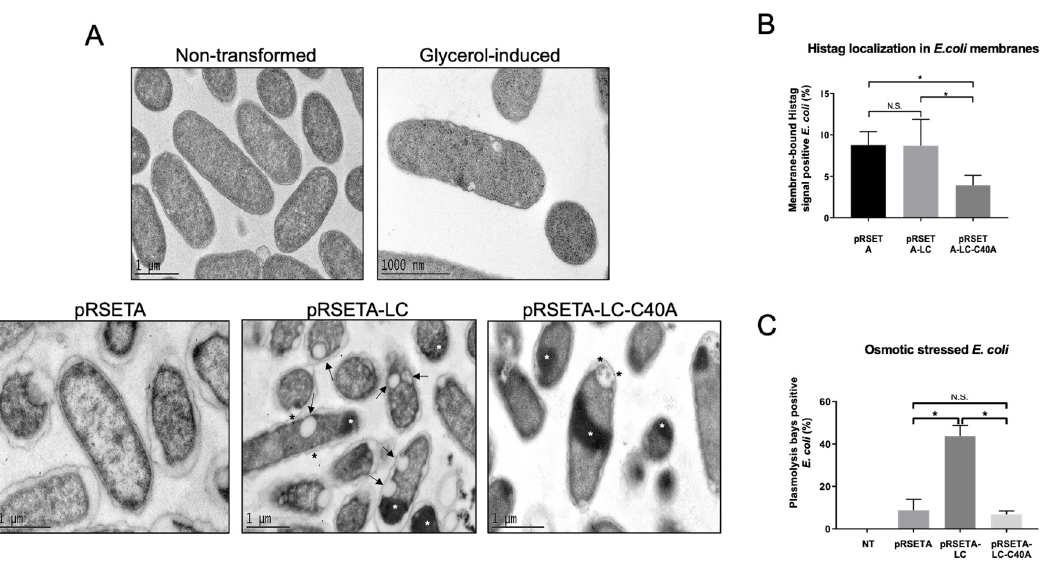
Figure 5. LC from FCV induces osmotic stress-like phenotype in E. coli. ( A ) TEM and immunogold labelling assays of pRSETA, pRSETA-LC, and pRSETA-LC-C40 transformed E. coli at 4 h post-induction with 1 mM IPTG using anti-Histag antibody. Non-transformed and glycerol osmotic stress-induced bacteria were used as controls. Inclusion bodies (white asterisks), nanogold particles (black asterisks), and plasmolytic bays (arrows) are indicated. ( B ) Statistical analysis of TEM micrographs to determine E. coli cells with Histag signal in their membranes, or ( C ) plasmolysis bays were quantified in each condition. Standard deviations were obtained from duplicates of at least three independent assays. Values of p ≤ 0.05 (*) or p < 0.0001 (*) calculated using GraphPad Prism 7.